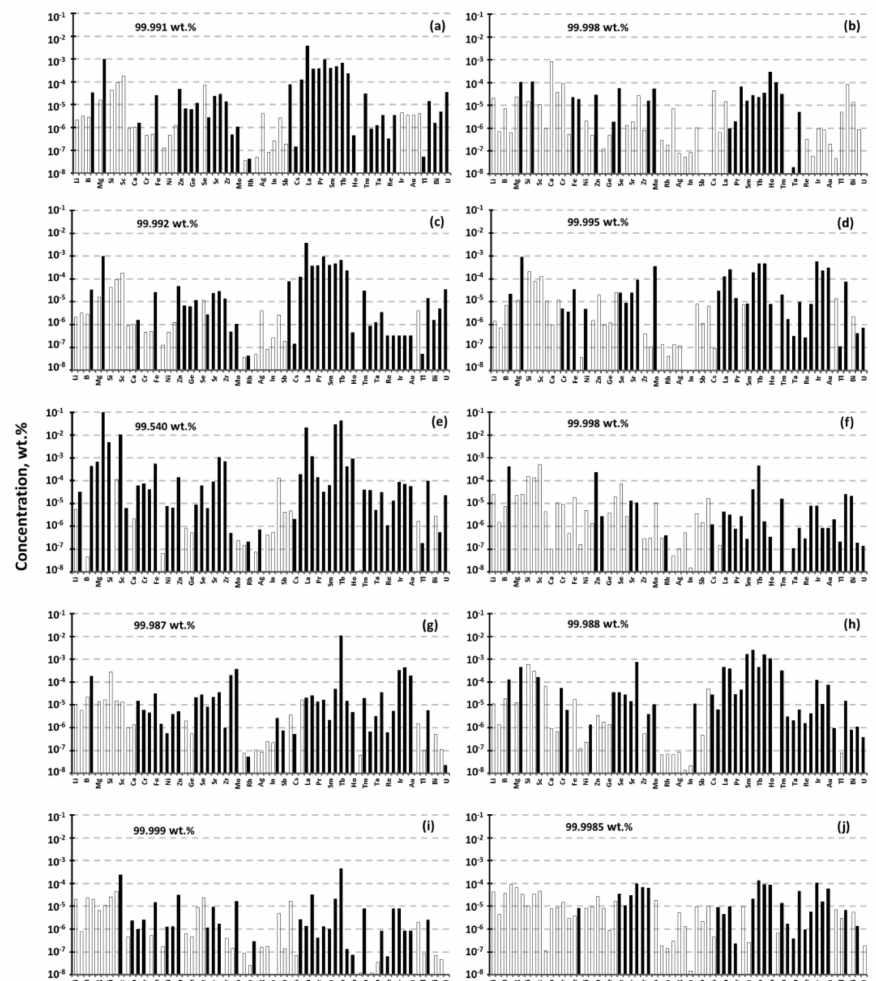
Figure 3. The impurity composition of gadolinium-based preparations of various manufacturers according to the results of ICP-MS analysis: ( a ) Gd 2 O 3 , American Elements; ( b ) Gd 2 O 3 , Party No. 1 (2018) Yeemeida Technology Co. Ltd.; ( c ) Gd 2 O 3 , Stanford Advanced Materials; ( d ) Gd 2 O 3 , Party No. 2 (2019) Yeemeida Technology Co. Ltd.; ( e ) Gd 2 O 3 IoLiTec (20–80 nm); ( f ) Gd 2 O 3 , FSUE “IREA”; ( g ) Gd(NO 3 ) 3 , FSUE “IREA”; ( h ) Gd 2 O 3 , “LANHIT” Ltd.; ( i ) GdCl 3 , “LANHIT” Ltd.; ( j ) Gd 2 O 3 Shin ETSU (Japan). The empty bars show the limits of determination of the